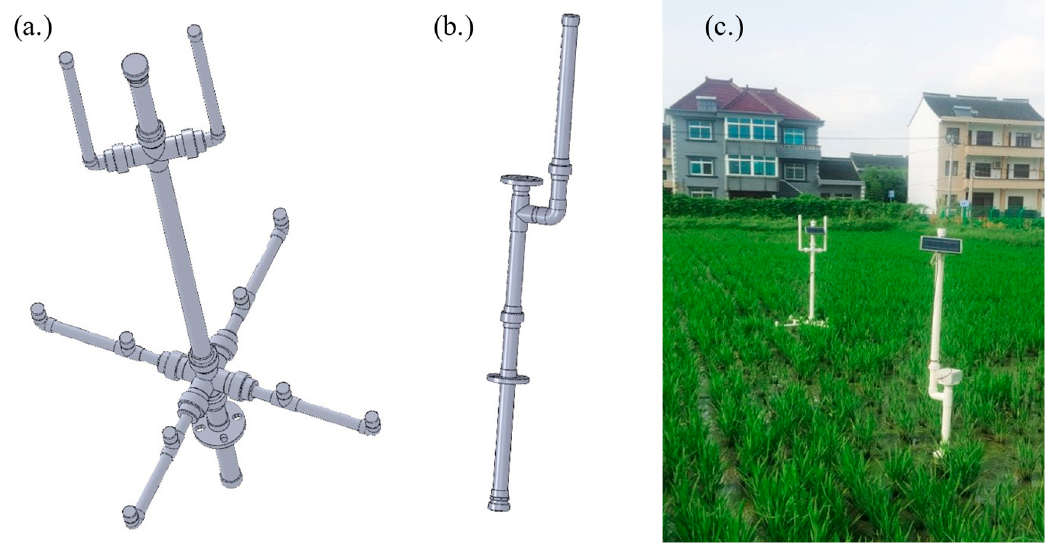
Figure 1. The concept diagram of light sensor array ( a ); the concept diagram of water level sensor ( b ); and the field photos of device ( c ).